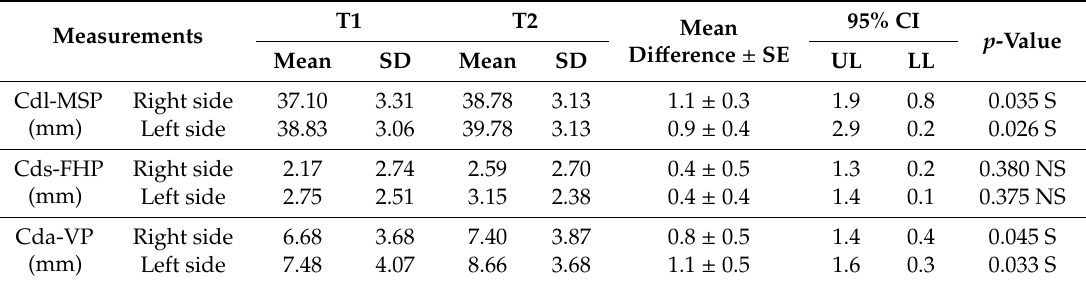
Table 4. Comparison of CBCT measurements (mm) of condylar position before and after twin block therapy in control group using paired t